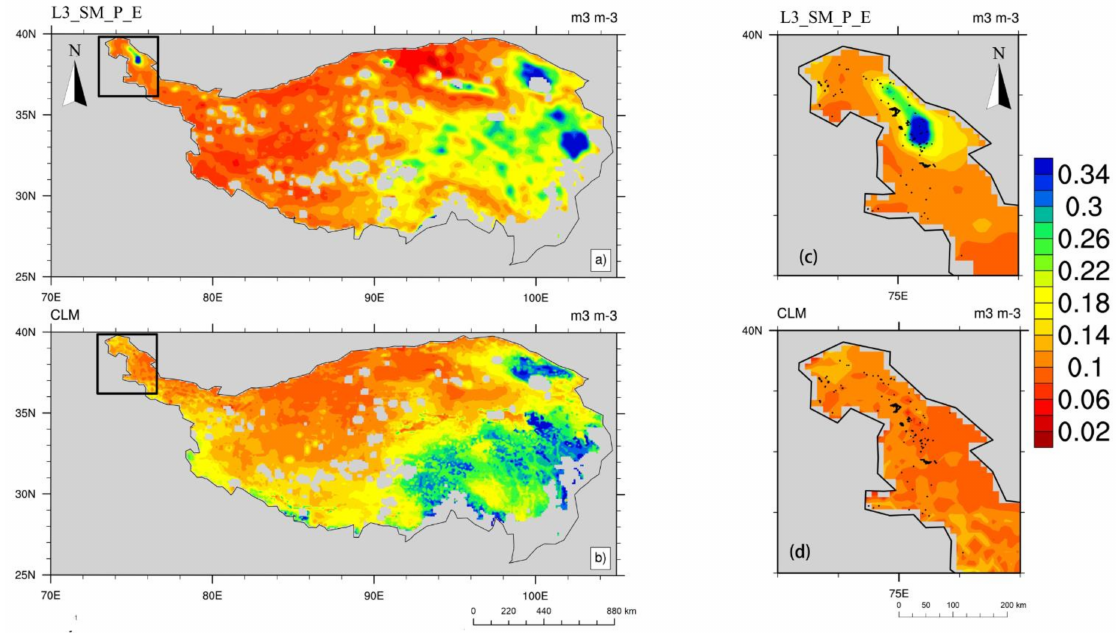
Figure 5. Spatial variations in summer soil moisture during 2016 based on: ( a ) the SMAP L3_SM_P_E product; and ( b ) the CLM simulation. ( c , d ) Spatial variations in soil moisture along with the distribution of lakes in the regions outline by black squares in ( a , b ) for the SMAP L3_SM_P_E product and the CLM simulation, respectively.